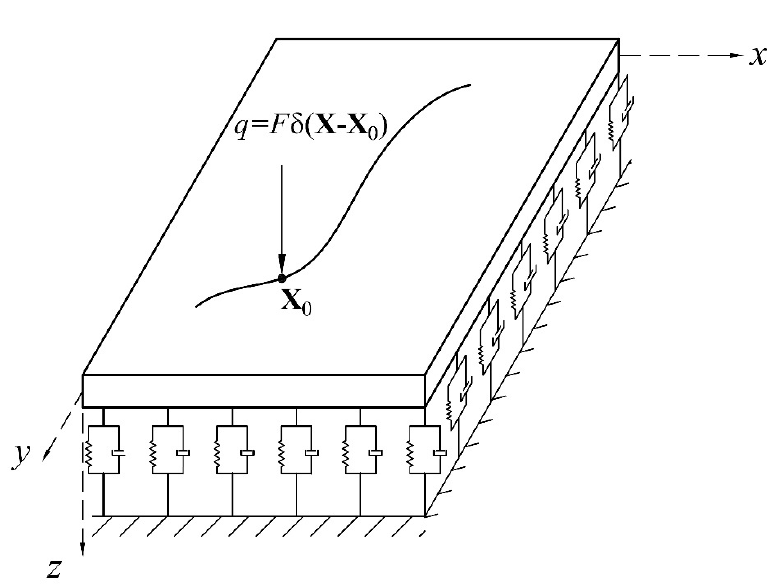
Figure 1. Schematic representation of a plate resting on viscoelastic foundation.